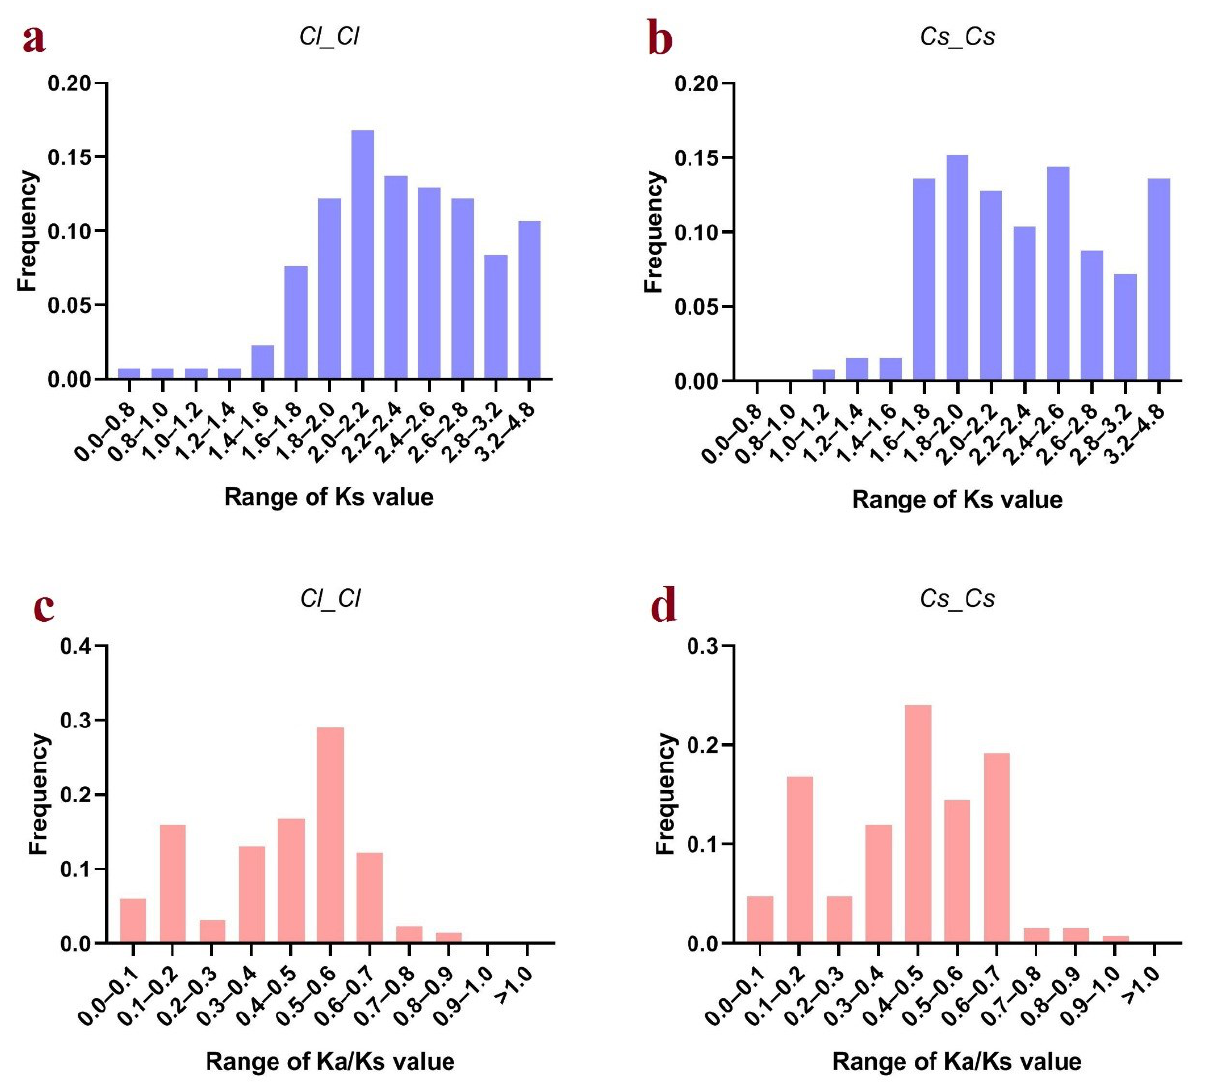
Figure 2. Ks value and Ka/Ks in MGTs in C. lanatus (Cl), and C. sativus (Cs). Frequency of Ks value between MGTs in C. lanatus ( a ) and C. sativus ( b ). Frequency of Ka/Ks ratio between MGTs in C. lanatus ( c ) and C. sativus ( d ).